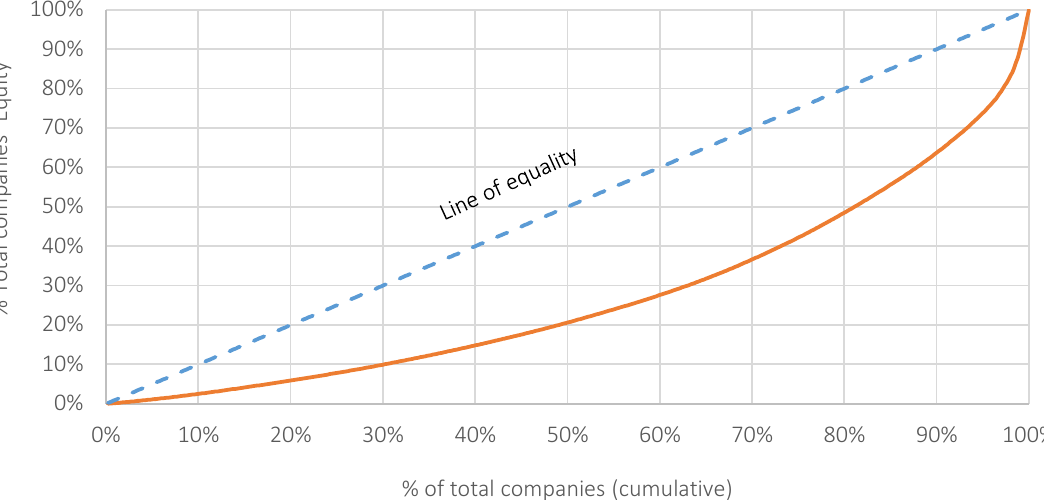
Figure 16. Lorentz curve of companies’ equity after 40 periods in Islamic LBO market